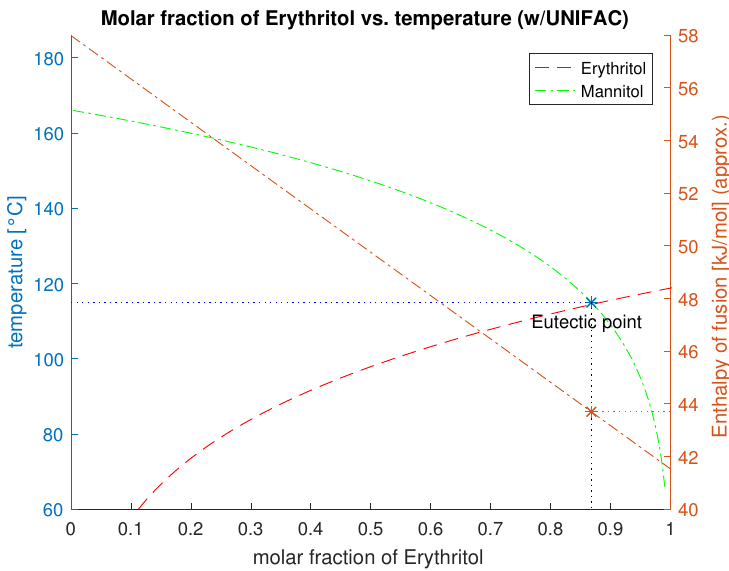
Figure 4. Phase diagram and liquidus line of the mixture Erythritol and D-Mannitol with their eutectic melting temperature and resulting enthalpy of